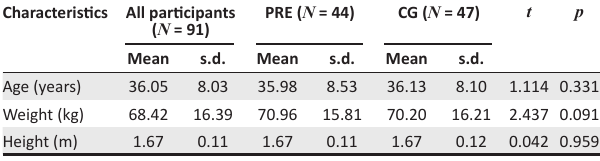
TABLE 1a: Socio-demographic status of the